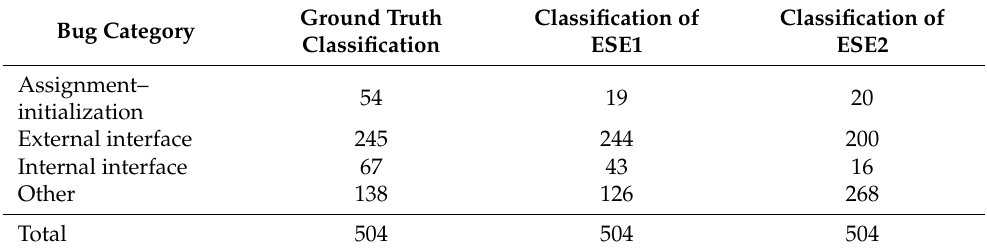
Table 4. Manual classification by two expert software engineers (ESE).